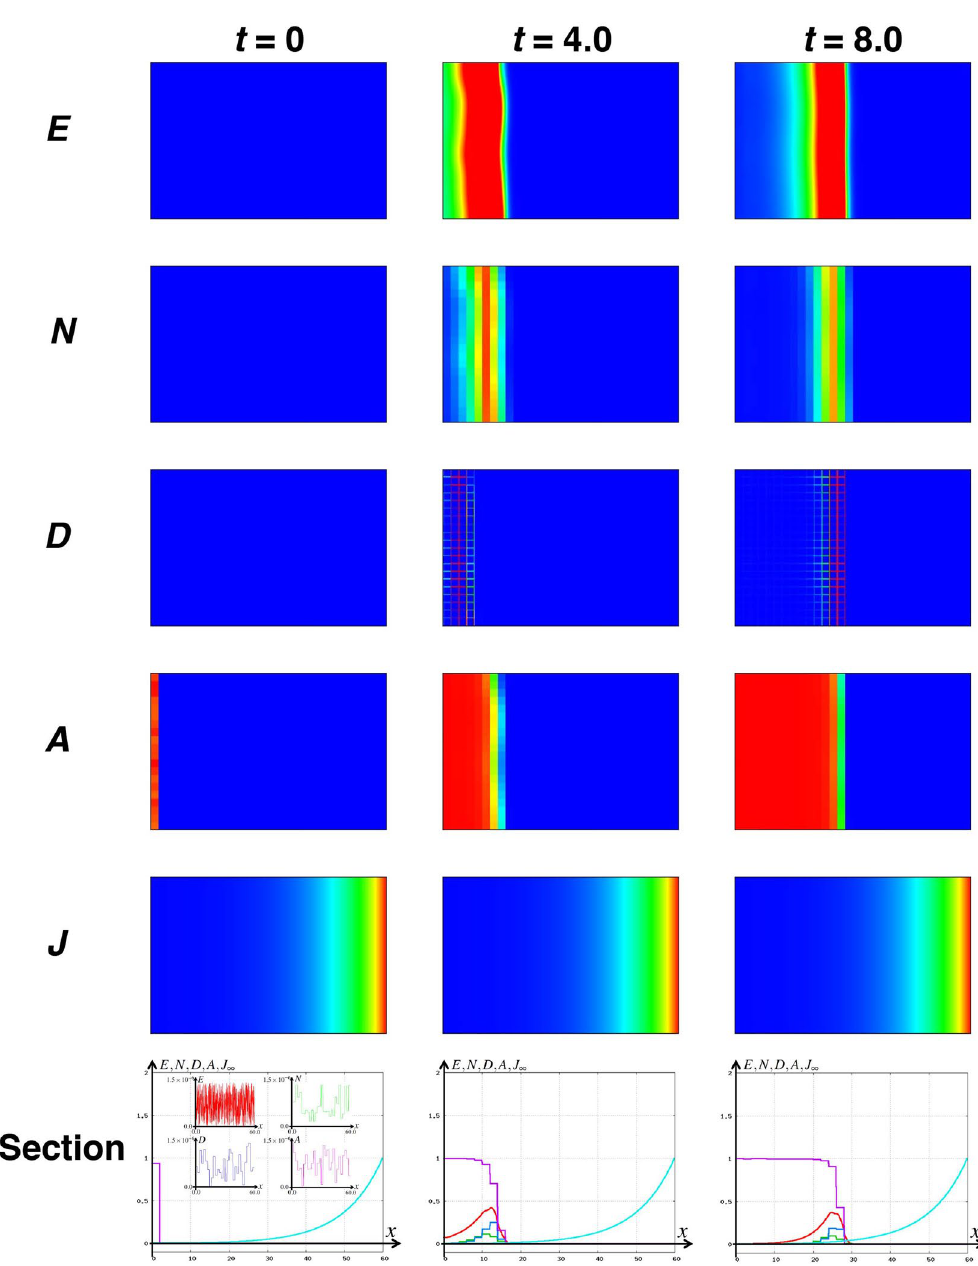
from the ligand source and it shows the same value along with the y axis. In the third formula, we set activation of JAK/STAT as 0 at the medial side and J 0 at the lateral side, since JAK/STAT activation was not found in the medial most region in the optic lobe and the activation in the lateral side was always strong (Fig. S1). We designate the improved version from eq. 2 as Model 2. We next performed the numerical simulations with Model 2 in a two dimensional field, B (Fig. 3). Even in the presence of a small perturbation in the initial condition and in each step of all variables, the proneural wave propagates similarly to the noise-free condition because of the cancelation of the noise. This is explained from the perspective of mathematical modeling: In Model 2, the term inhibiting the differentiation of A is reproduced by the function max{ E i , j − N i , j − k in J ∞ , 0}. If the concentration of E i , j , which can promote the propagation of the proneural wave, is larger than that of N + k in J ∞ , which inhibits the propagation